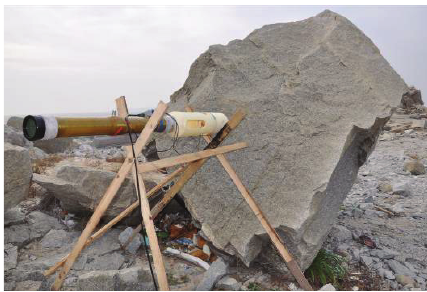
Figure 6: Setup diagram of blasting experiment with breaking and blasting equipment.